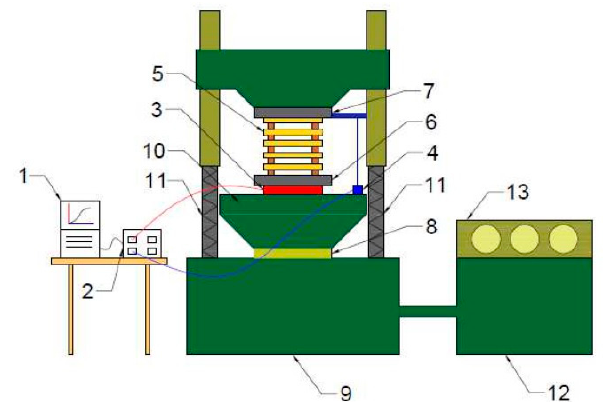
Figure 7. A scheme of the laboratory stand: 1—computer, 2—measuring amplifier, 3—force sensors, 4—displacement sensor, 5—model of crib, 6—lower base, 7—upper base, 8—hydraulic cylinder, 9—